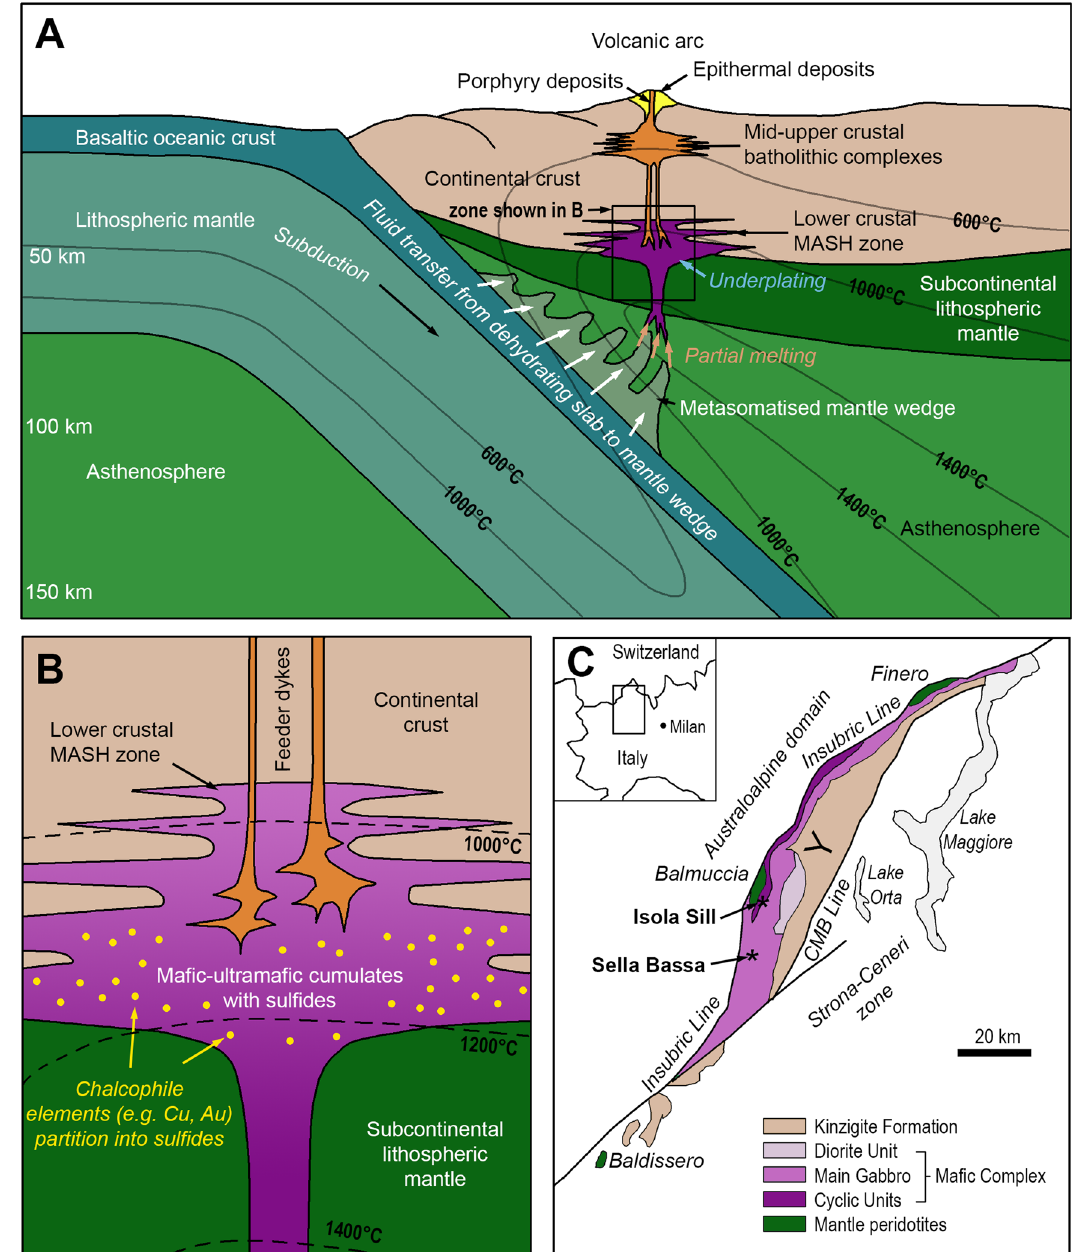
Fig. 1 Geological setting of lower crustal cumulate bodies in arcs. A Generalized cross-section of a subduction zone, with associated metasomatism and magmatism (after Richards 3 , Wilkinson 5 ) showing the location of the lower crustal MASH zone. B Schematic representation of sul fi de supersaturated ma fi c-ultrama fi c cumulates in the MASH zone. Note the general isotherms for the base of the crust in this zone indicate a probable temperature range of above 1000 °C within the cumulates after emplacement. C Geological map of the Ivrea Zone, northern Italy, showing the generalized stratigraphy and the location of the Isola and Sella Bassa sampling sites. CMB Cossato – Mergozzo – Brissago. Modi fi ed after 32,53